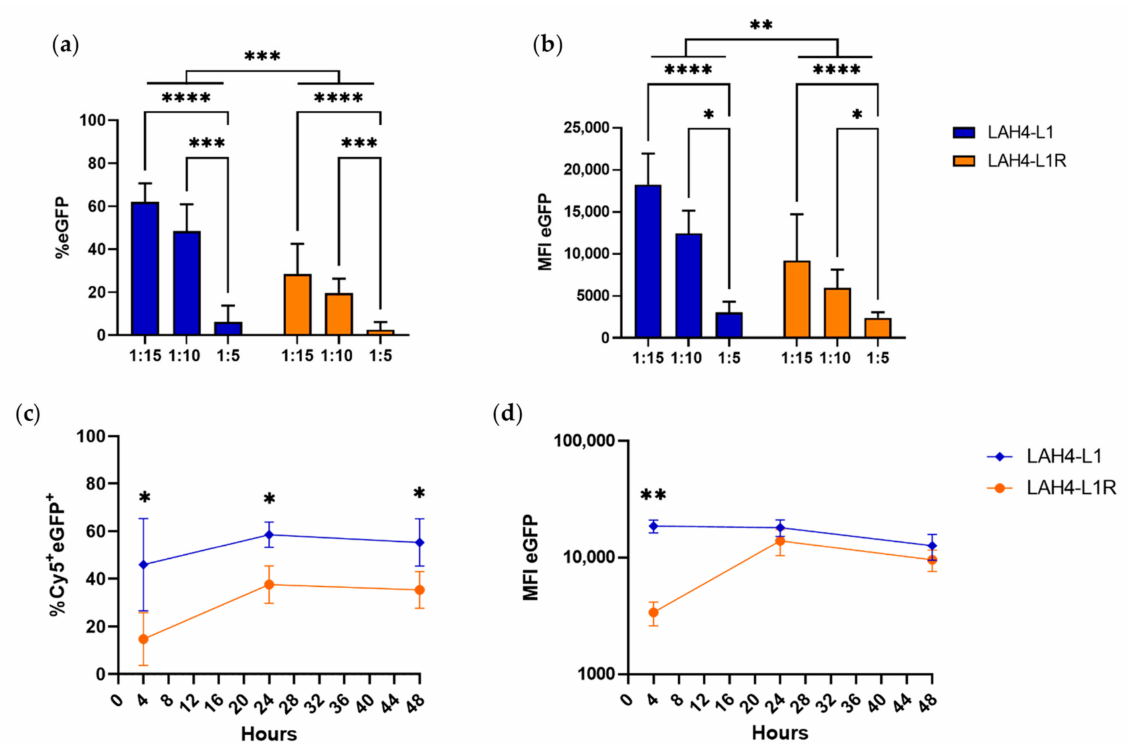
Figure 3. Histidine-rich peptides allow efficient transfection in DC2.4 cells. DC2.4 cells were trans- fected with 250 ng of mRNA encoding eGFP per 200,000 cells at the indicated mRNA:HPR ratios ( µ g: µ g). The next day, the cells were harvested, and readout was performed by flow cytometry for percentage ( a ) and MFI ( b ) of eGFP ( n = 4, mean ± SD). Two-way ANOVA, Tukey’s multiple compar- ison test: * p < 0.05, ** p < 0.01, *** p < 0.001, **** p < 0.0001. DC2.4 cells were transfected at a 1:15 ratio ( µ g mRNA: µ g HRP) with 125 ng of Cy5-labelled mRNA encoding eGFP per 100,000 cells. Readout was performed after 4, 24, and 48 h by flow cytometry for detection of the percentage of Cy5 + eGFP + cells ( c ) and the MFI of eGFP ( d ) ( n = 3, mean ± SD). Welch’s t-test: * p < 0.05, *** p < 0.001. The positive control (jetMessenger ® ) and negative controls (without mRNA) are not shown on the